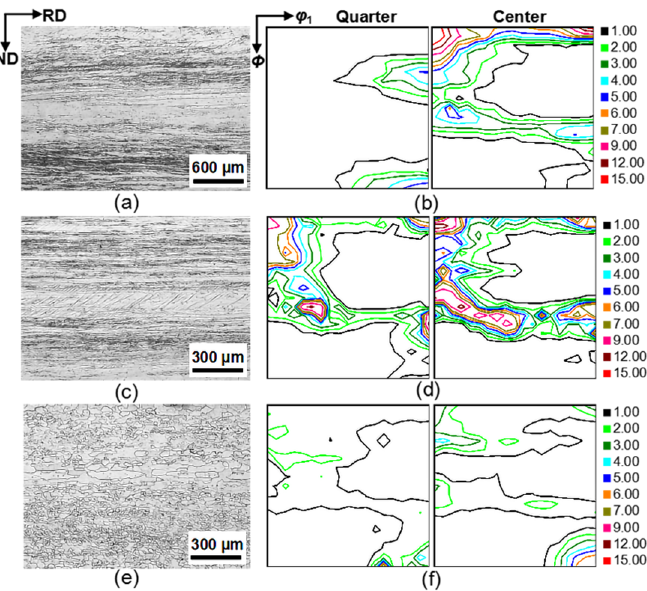
Figure 1. Microstructure and φ 2 = 45° ODF sections in ( a , b ) hot-rolled strips, ( c , d ) first-stage cold-rolled sheets, and ( e , f ) intermediate annealed sheets of the Fe 81 Ga 19 alloy.